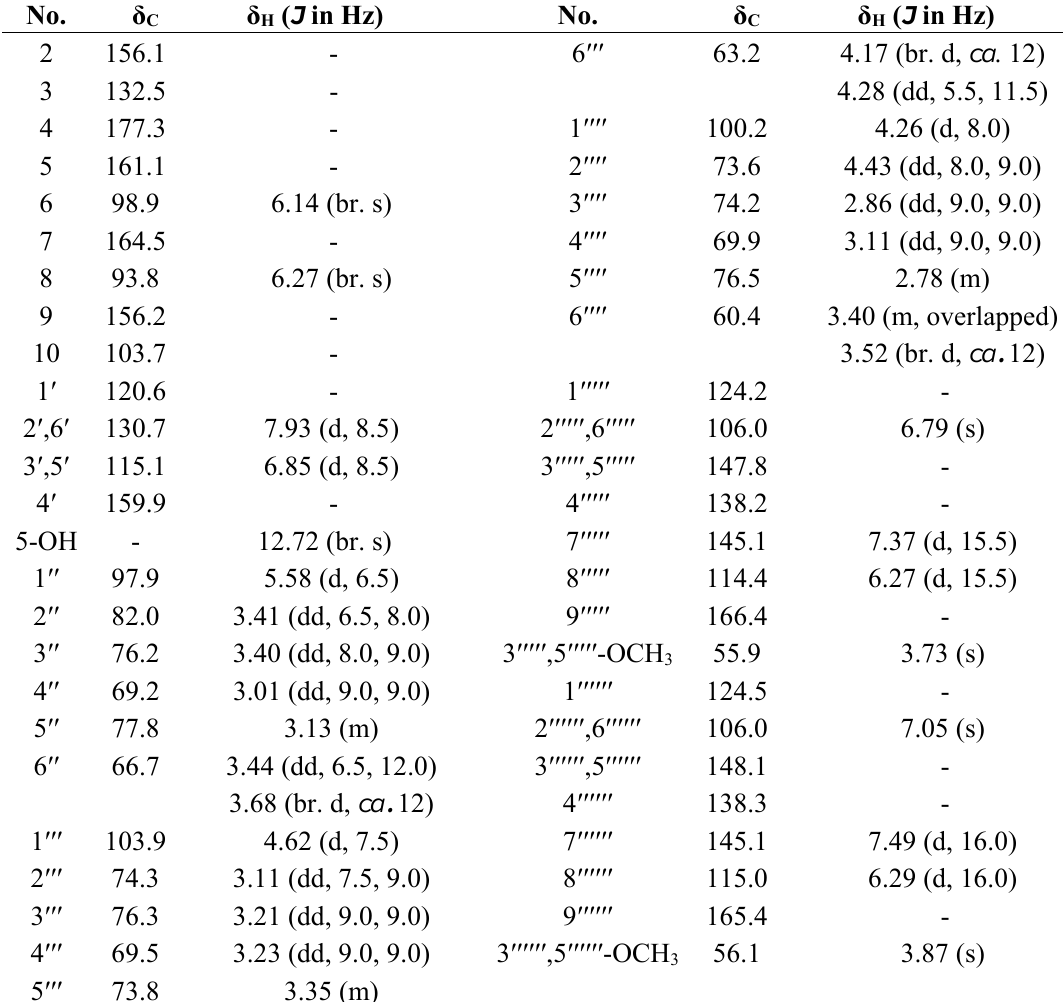
Table 7. 1 H and 13 C-NMR data for 7 in DMSO- d 6 (500 MHz for 1 H and 125 MHz for 13